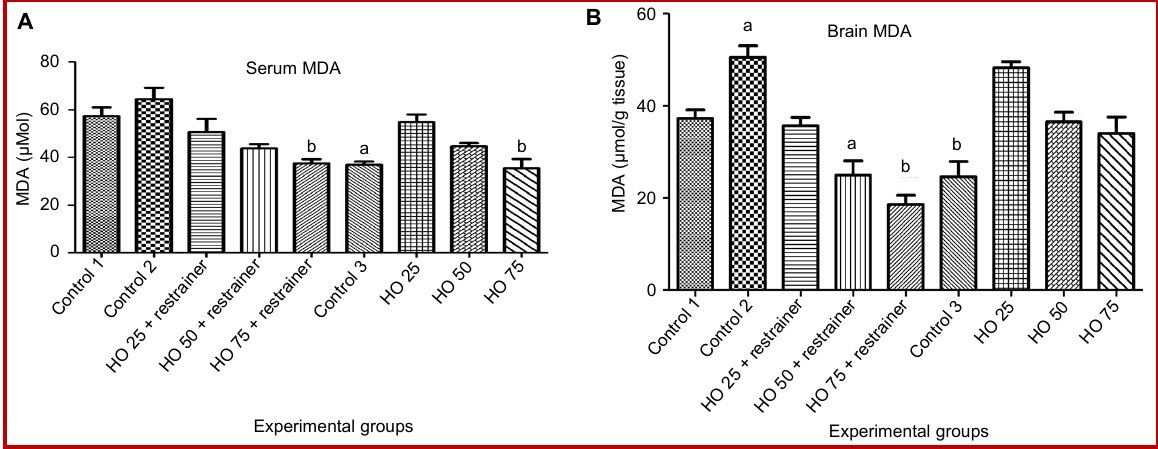
Figure 3: Serum (A) and brain (B) malondialdehyde levels in different groups; all groups are compared with control group 1. a Sig- nificant difference compared to control 1 group (p<0.01); b significant difference compared to control 1 group (p<0.001); HO: Hys- sopus officinalis